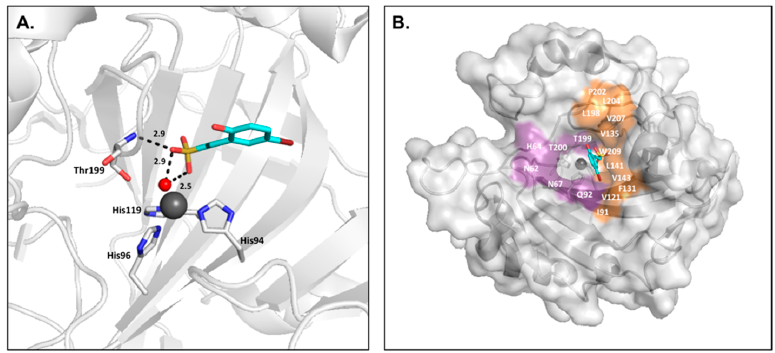
Figure 9. ( A ) CA ΙΙ ( gray ) in complex with sulfocoumarin inhibitor ( E )-2-(5-bromo-2-hydroxyphenyl) ethenesulfonic acid ( cyan ) (PDB:4BCW); ( B ) Surface representation of CA II in complex with sulfocoumarin inhibitor [53].